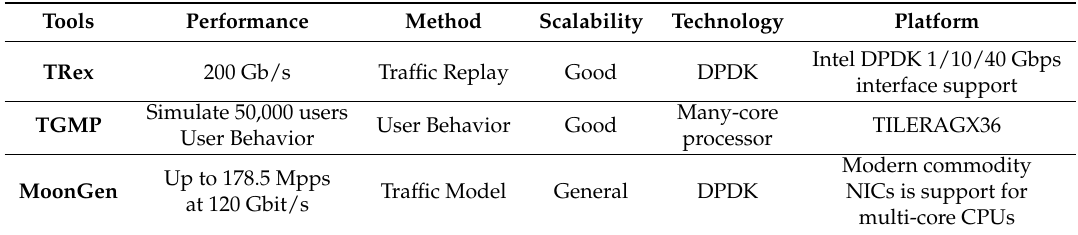
Table 3. Compared with well-known